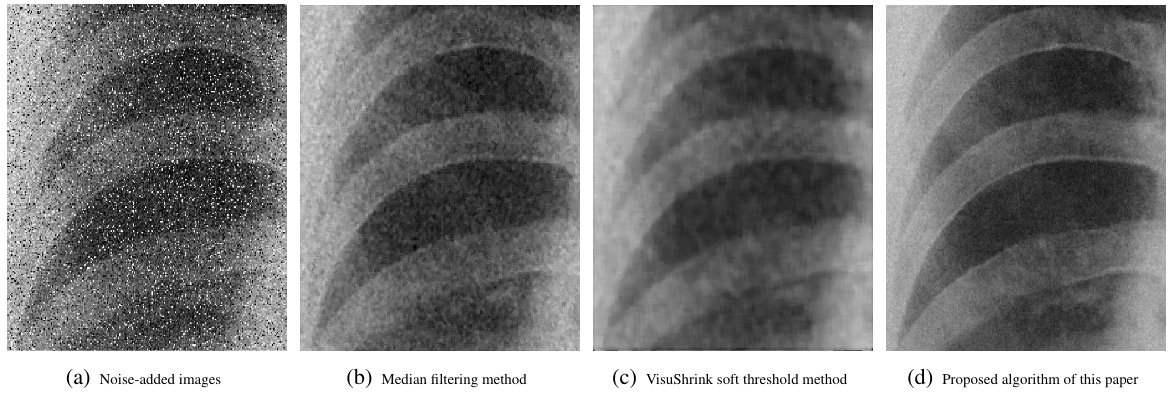
Fig. 3 Compare the filtering